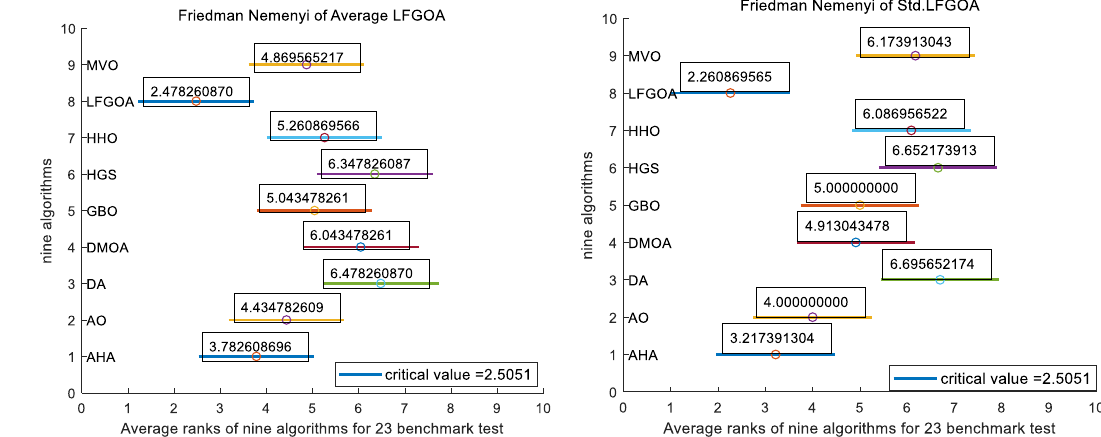
Figure 3. Average rank of Mean (left side) and Average rank of Std (right side) about LFGOA and the other algorithms using Friedman’s test based upon their results on the 23 test Fig. 6, the graph focus on the best fitness history of the LFGOA algorithm on each of the F1–F23 benchmark functions respectively.